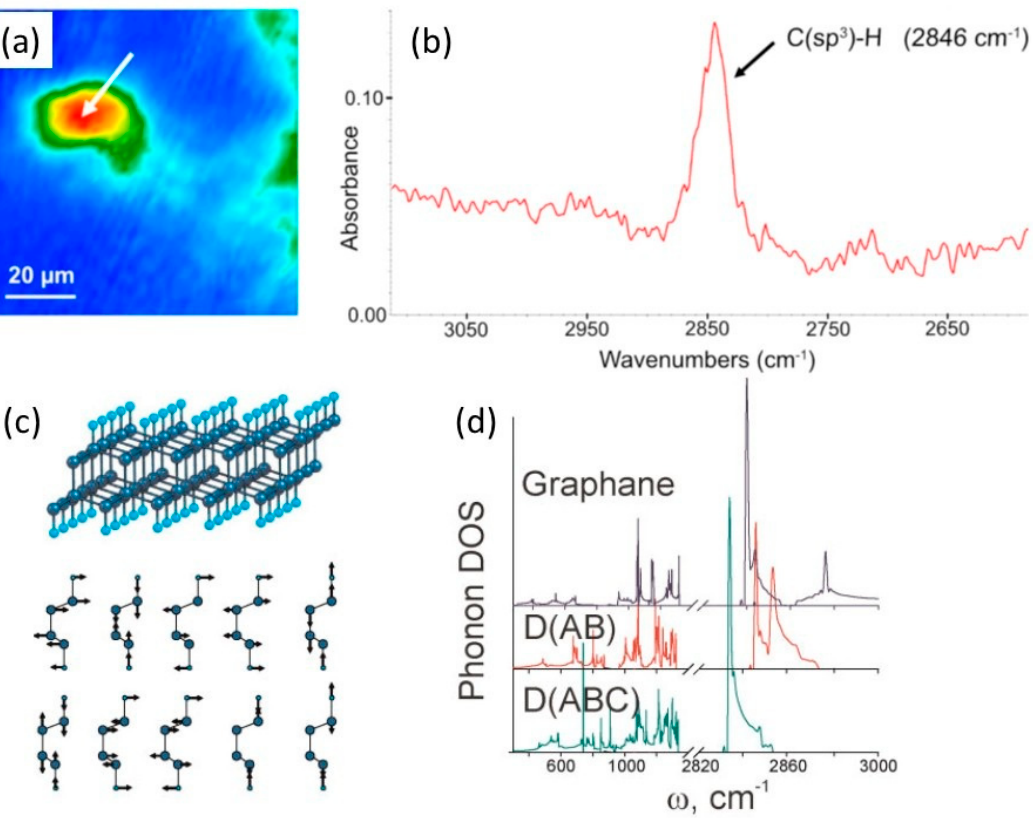
Figure 10. ( a ) FTIR mapping of a large-sized circular area of ~150 mm 2 containing C-H bonds (marked by the arrow) and ( b ) absorbance spectra taken in the region identified by an arrow [37]. ( c ) Calculated atomic structure and vibration pattern of optical modes of diamane and ( d ) phonon densities of the states of graphane and diamanes [39].